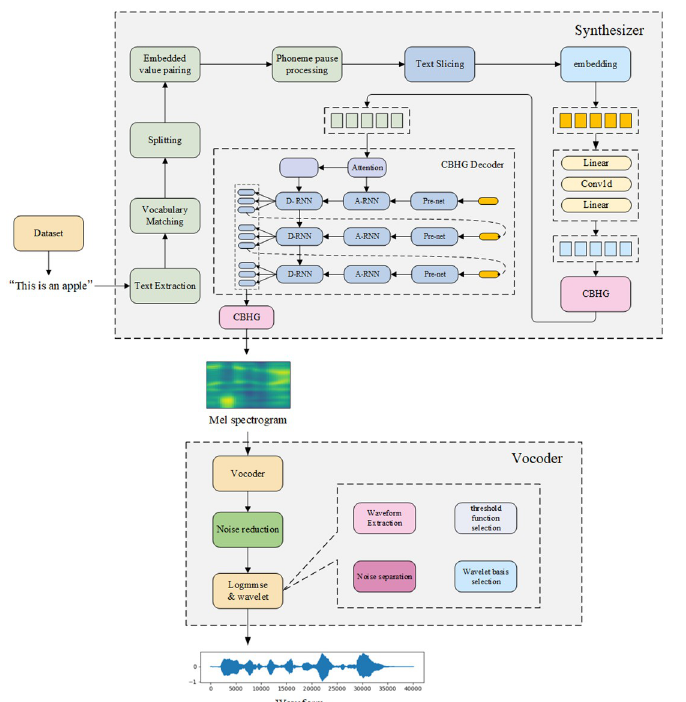
Fig 2. Voice basic